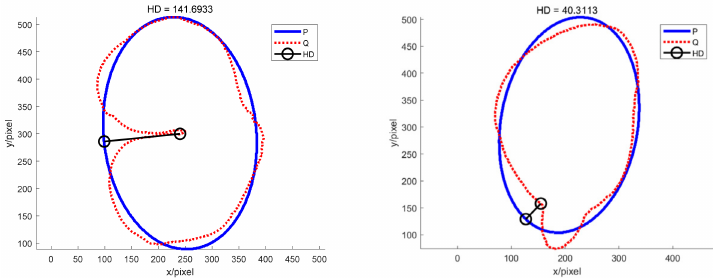
Figure 10. Hausdorff distance calculation results for irregular potatoes.